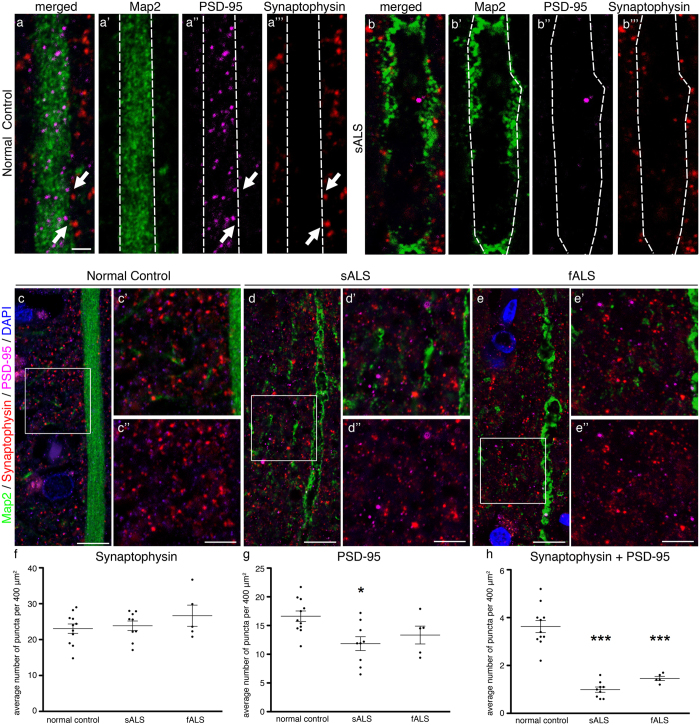
Post-synaptic densities are decreased in ALS motor cortex.(a,b) Representative images of Map2 (apical dendrites), synaptophysin (pre-synaptic terminals), and PSD-95 (post-synaptic zone) immunocytochemistry in normal control (a), and sALS (b) motor cortex. Dashed lines represent apical dendrite boundaries. Arrows point to pairs of PSD-95 puncta inside the dendrite and synaptophysin puncta outside the dendrite, within close proximity of each other. (c–e) Representative areas used for quantification of synaptic puncta density in normal control (c), sALS (d) and fALS (e) motor cortices are boxed, and enlarged (c’,d’,e’). Green channel is removed for easier observation of synaptic staining (c”,d”,e”). (f–h). Scatter plots represent mean average ± SEM number of puncta per 400 μm2 (20 μm × 20 μm) area quantified in all cases studied. Normal controls versus diseased cases studied *P < 0.05, ***P < 0.001. One-way ANOVA (Kruskal-Wallis test) with post hoc non-parametric Dunn’s multiple comparison test. Abbreviations: NC: normal control, sALS = sporadic ALS, fALS = familial ALS. (a,b) scale bar = 2 μm, (c–e) scale bar = 10 μm, (c’,c”,d’,d”,e’,e”) scale bar = 5 μm.